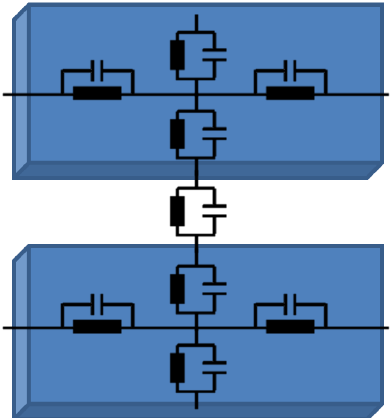
Figure 6. An equivalent circuit representation for the electrical properties of a slice of